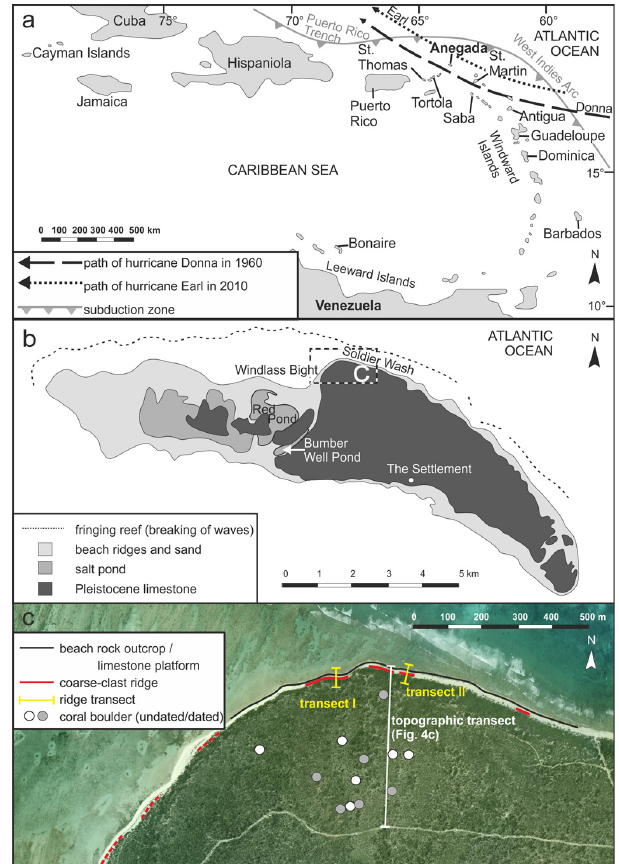
Fig. 1. (a) Map of the Caribbean Sea. (b) Generalized geologic map of Anegada. (c) Detailed view of the central north shore indicating the location of the coral-rubble ridge, the surveyed transects, sites of (tsunamigenic?) coral boulders and the location of the topographic profile in Fig. 4c (Weil Accardo et al.,